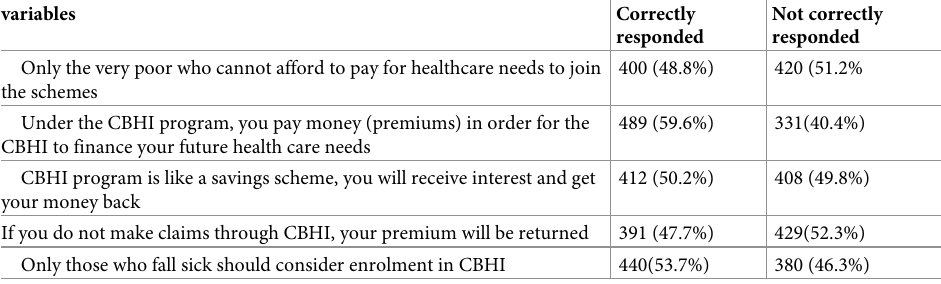
Table 2. Knowledge of the study participants related to CBHI in Segen area and South Omo zones, Southern, Ethiopia 27 April to 12 June 2018.